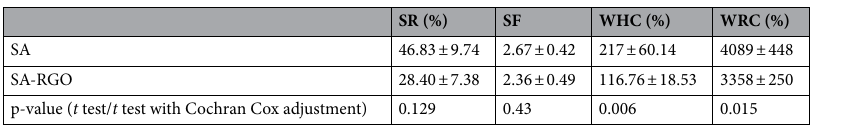
Table 2. Water-related properties of the investigated carriers: SR swelling ratio, SF shrinking factor, WHC water holding capacity, and WRC water retention capacity. The data is presented as a means value ± standard deviation, α =